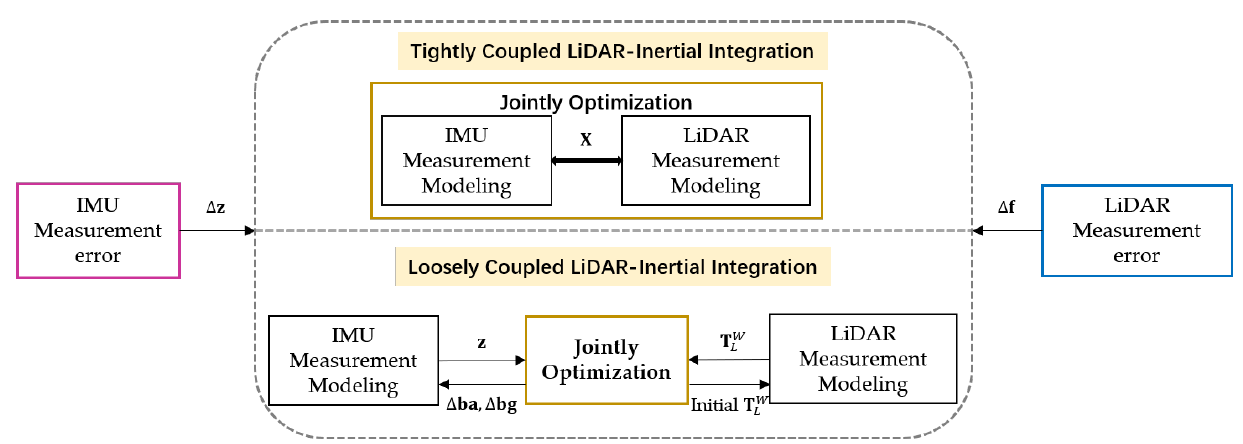
Figure 6. Error propagation in the LiDAR scan-to-map registration for TC-LIO and LC-LIO. An error of IMU measurements and LiDAR measurements are represented as Δ𝐳 and Δ𝐟 , respectively. For TC-LIO, 𝐗 represents the states to be estimated during LiDAR-Inertial integration. LiDAR measurement modeling is directly affected by both Δ𝐳 and Δ𝐟 . For LC-LIO, LiDAR scan-to-map registration is only disturbed by Δ𝐟 , which is the error of its own.